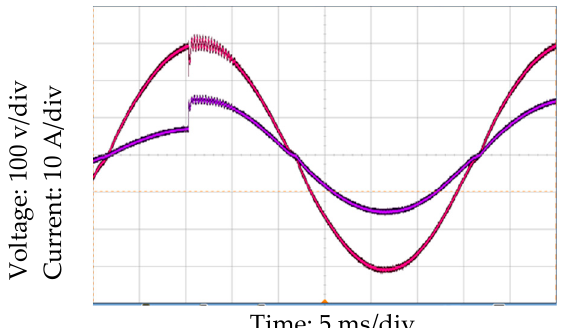
Figure 9. Experimental results of the output voltage and the load current.